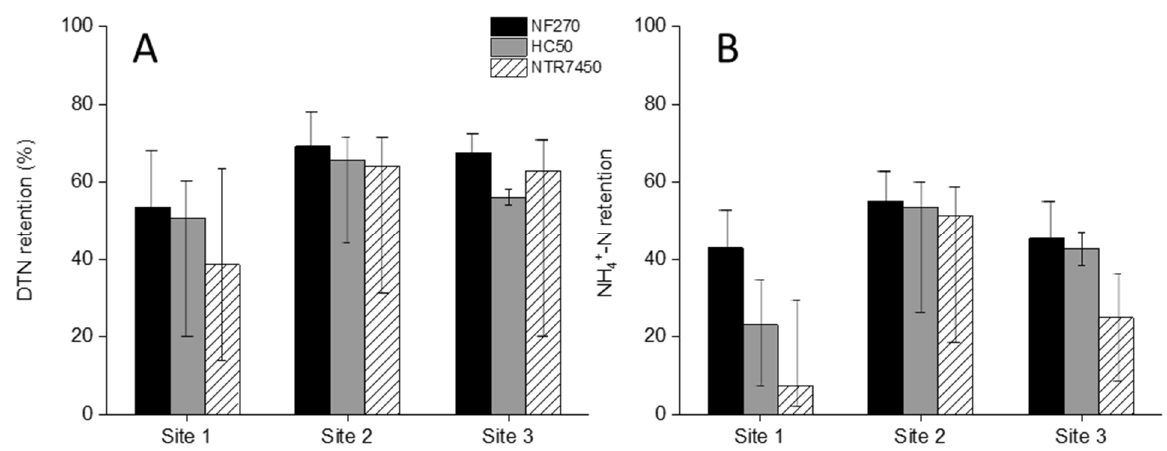
Figure 3. ( A ) DTN and ( B ) NH 4+ -N retention of MF permeate at 50% recovery by NF270, HC50, and NTR7450 membranes from all sampling sites. Pressure: 6.5 bar; stirring rate: 400 rpm; temperature: 25 °C.